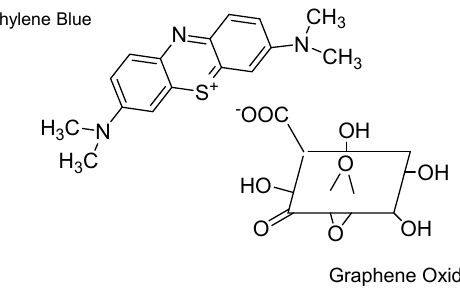
Figure 8. Electrostatic interaction between MB and GO.